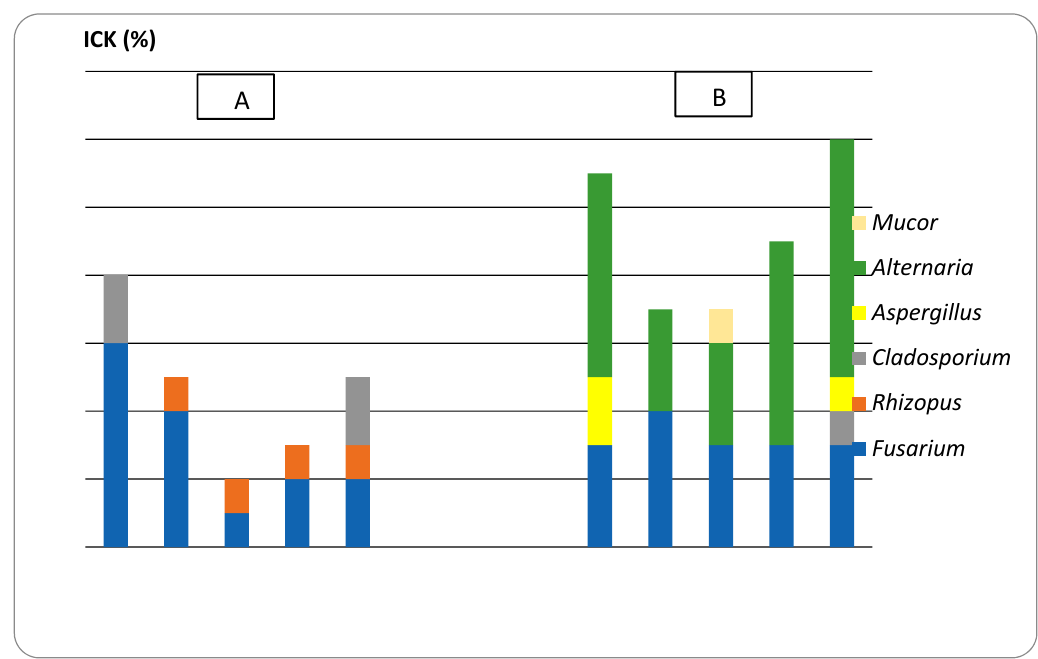
Figure 2. The index of colonization of wheat kernels (ICK, %) after ( A ) 7 days and ( B ) 14 days of fumigation with EOs; CEO (0.6%), CS1 (CEO 10% + SEO 2%), CS2 (CEO 1% + SEO 0.2%), CS3 (0.5% + SEO 0.1%). Data are presented as mean ± SD from two independent experiments (n = 2).